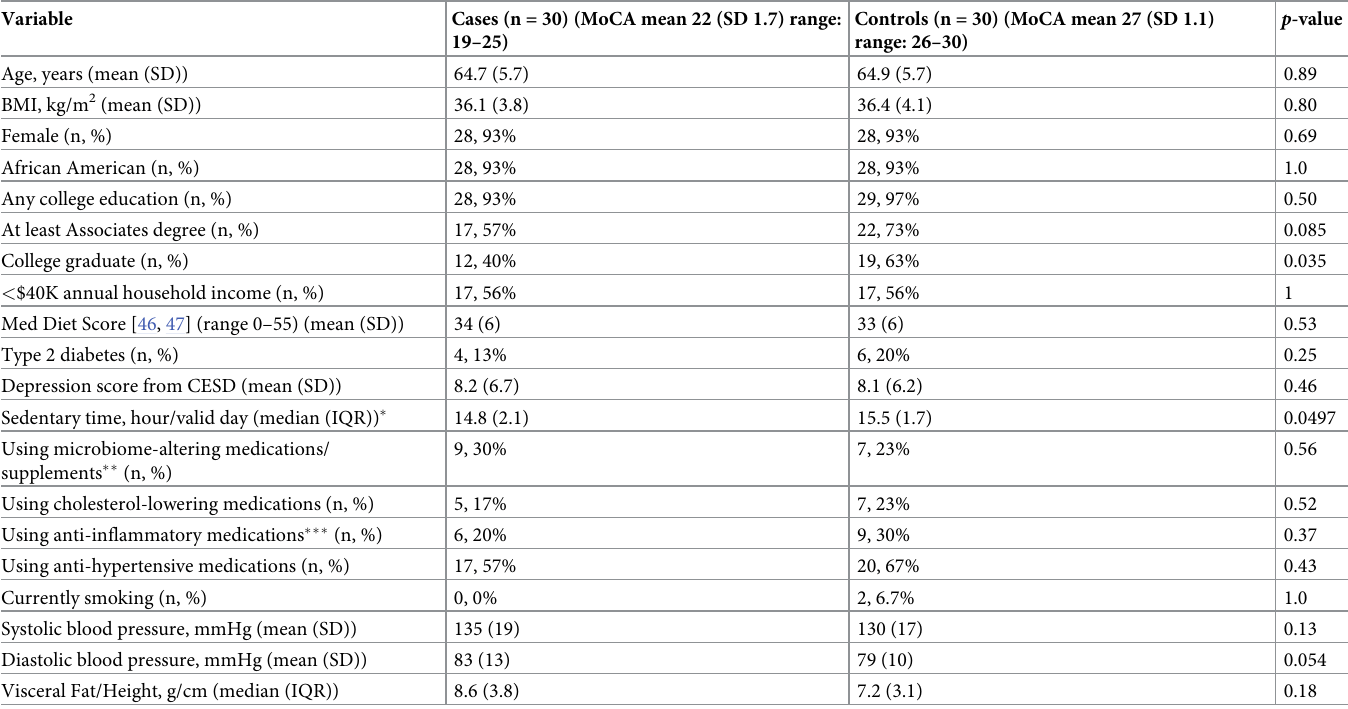
Table 1. Participant characteristics stratified by case control